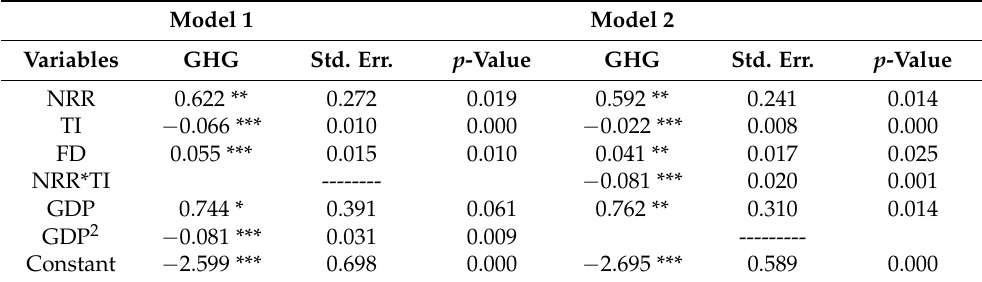
Table 6. Robustness checks with the CCEMG method (full